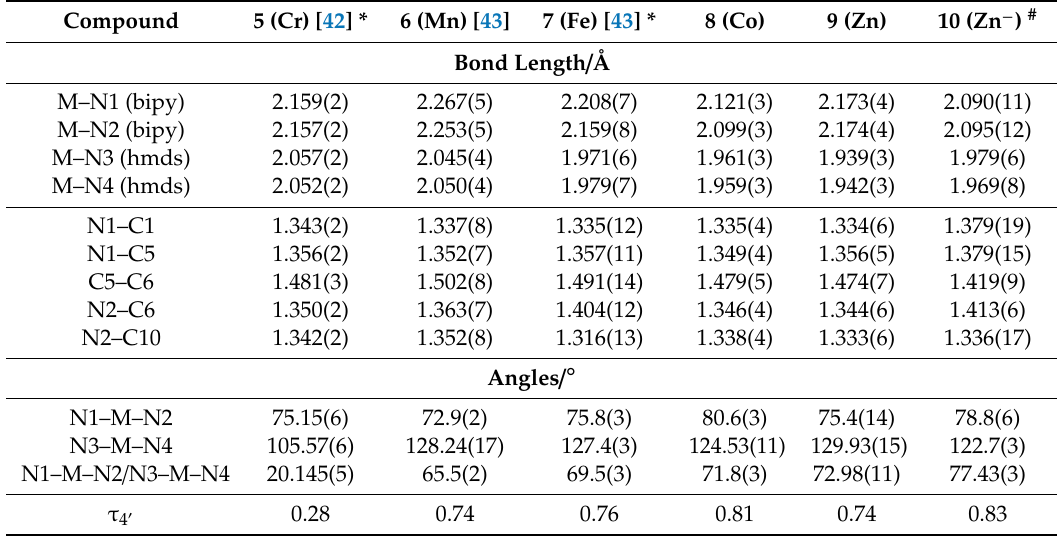
Table 2. Important structural metrics of compounds 5 – 9 as well as of the complex anion